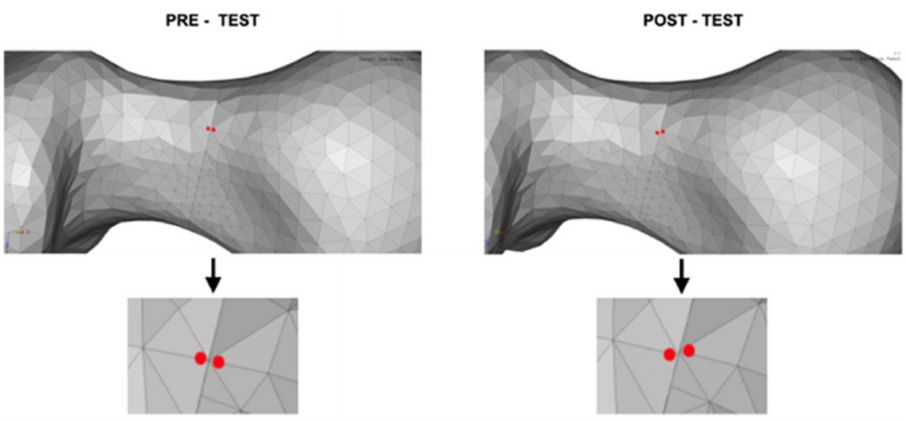
Figure 5. Upper left, nodes on the anterior face of the femoral neck selected for rotation deviation assessment (pre-test). Upper right, skewed nodes (post-test). In the two lower images, the pre- and post-test nodes at higher magnification. Observe that nodes are shown in red color in both